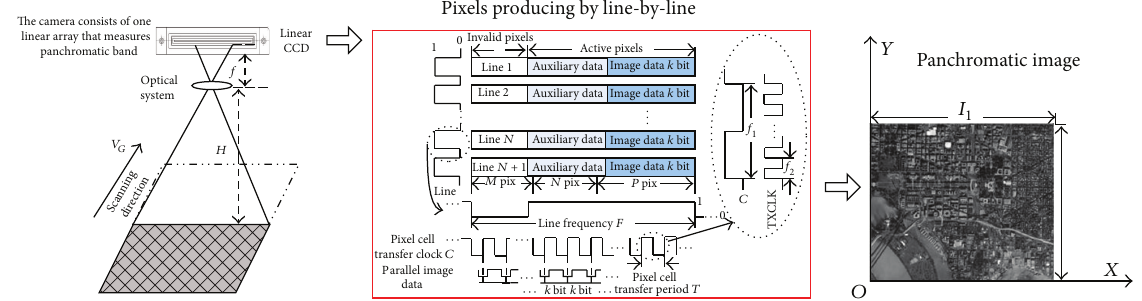
Figure 3: Imaging principle of